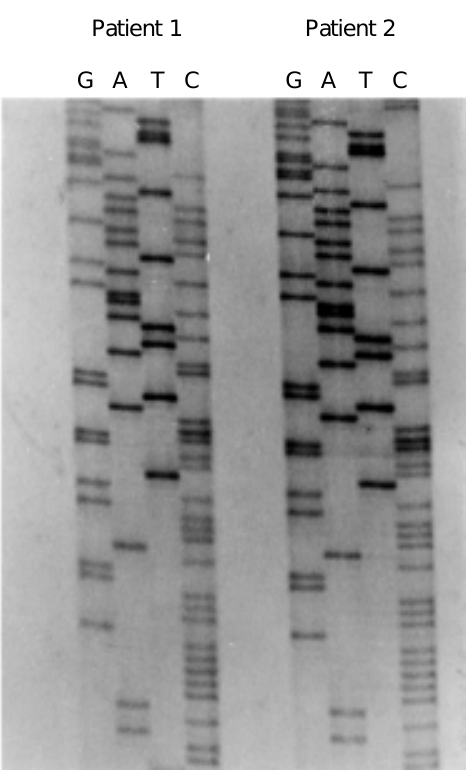
Figure 1 - Wild type p53 exon 5 sequencing from codon 149- TCC to codon 176-TGC in biopsy specimens from patients 1 and 2. The treated PCR product was sequenced by the dideoxy chain termination method with the Sequenase version 2.0 DNA se- quencing